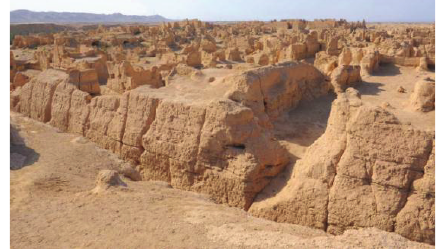
Figure 1: Gaochang Ruins panoramic view.